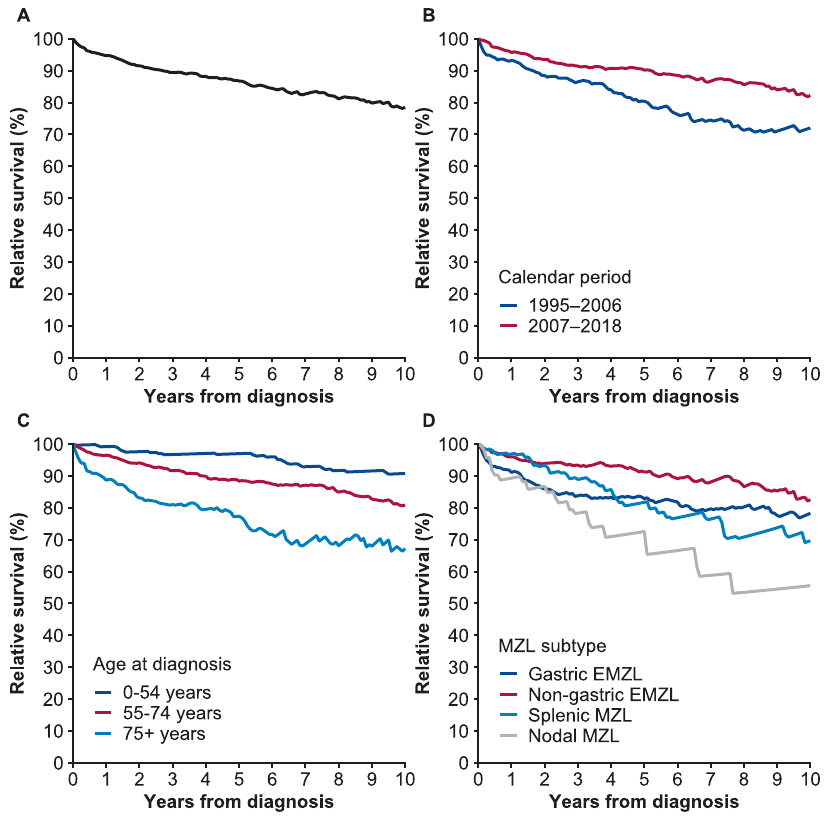
Fig. 4 Relative survival in patients diagnosed with marginal zone lymphoma in Finland in 1995 – 2018. A Ten-year age-standardized relative survival for 1995 – 2018; B Ten-year age-standardized relative survival for 1995 – 2006 and 2007 – 2018; C Ten-year age-speci fi c relative survival; D Ten-year age-standardized relative survival by subtype. MZL marginal zone lymphoma, EMZL extranodal marginal zone lymphoma.